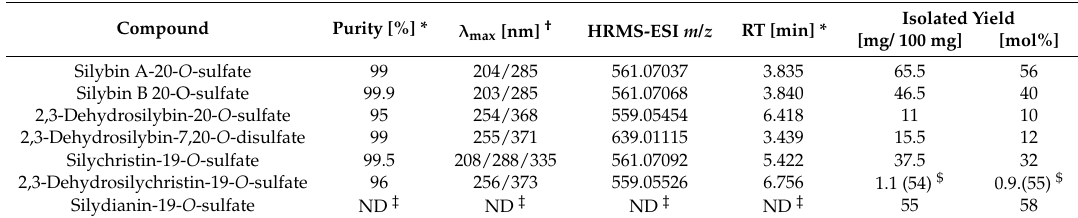
Table 2. Isolated flavonolignan sulfates, their purity, analytical characteristics, and